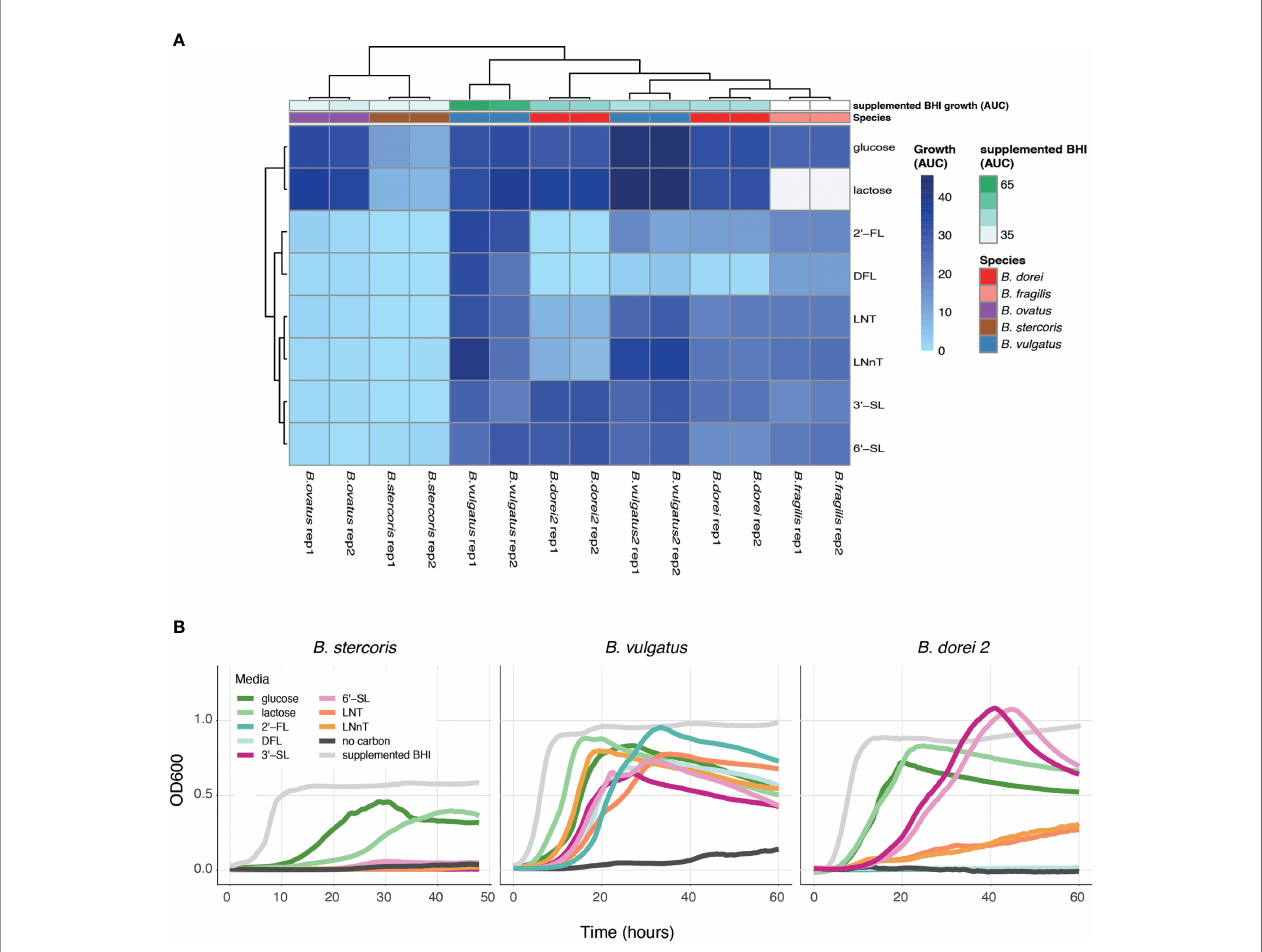
FIGURE 2 | HMO utilization ability varies across Bacteroides isolates. Growth curves were measured for all chosen strains and all chosen sources (0.5% weight/ volume): glucose, lactose, 2-Fucosyllactose (2 ’ -FL), Difucosyllactose (DFL), 3-Sialyllactose (3 ’ -SL), 6-Sialyllactose (6 ’ -SL), Lacto-N-Tetraose (LNT) and Lacto-N- neotetraose (LNnT), supplemented BHI media (positive control), no carbon media (negative control). (A) Area under the curve (AUC) of the growth curve plots, shown in two biological replicates for each strain. Missing data is represented by white cells, in both heat map and annotations. (B) Growth curve plots of B. stercoris , B. vulgatus and B. dorei 2 on all selected carbon